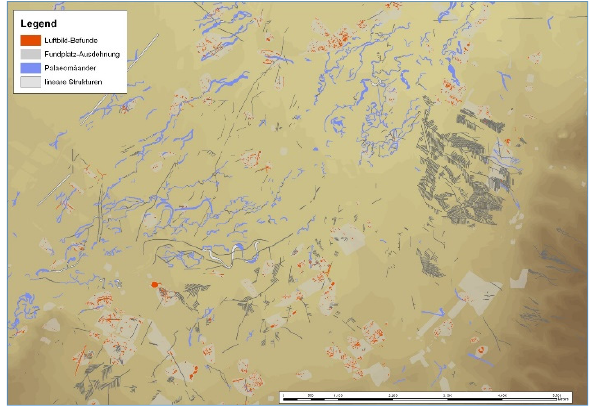
Figure 7: Map of all archaeological and palaeoenvironmental structures, stored as shapefiles of the respective site and automatically loaded into the GIS environment by